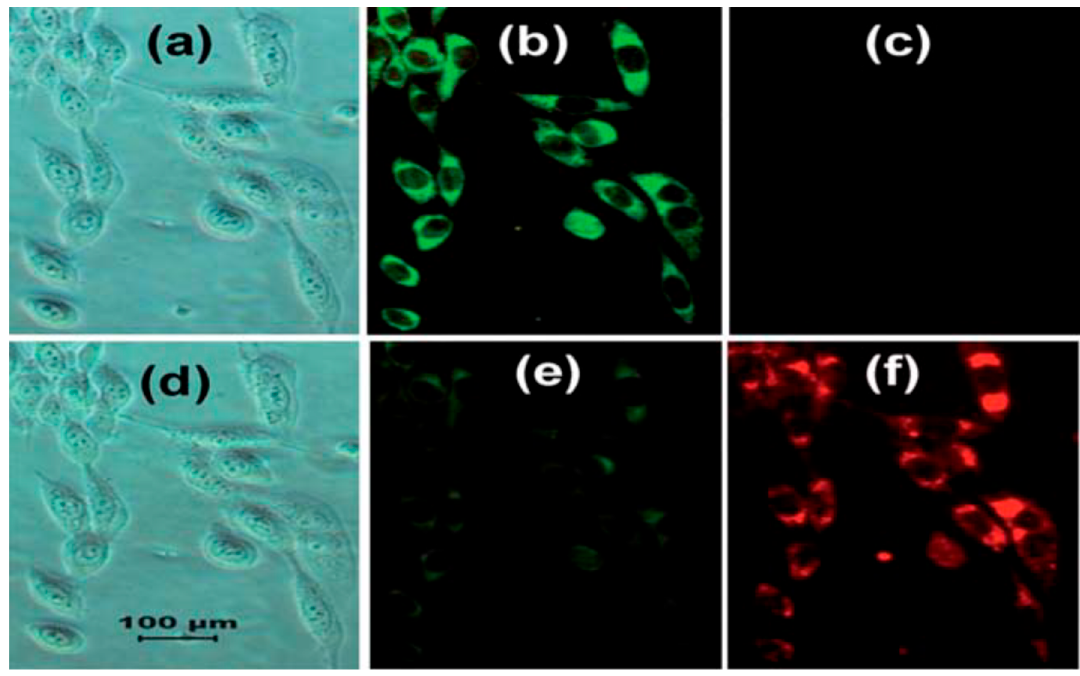
Figure 5. Bright-field and fluorescence microscopic images of NIH 3T3 cells obtained using a Leica DM IRB microscope equipped with an EBQ-100 UV-lamp. Top row: NIH 3T3 cells incubated with 56 (5 mM) for 30 min and observed under bright-field ( a ), green channel ( b ), and red channel ( c ). Bottom row: NIH 3T3 cells incubated with 56 (5 mM) for 30 min, treated with Fe 3+ (5 mM) for 15 min, and observed under bright-field ( d ), green channel ( e ), and red channel ( f ) (Reproduced from Ref. [64] with permission from The Royal Society of Chemistry).